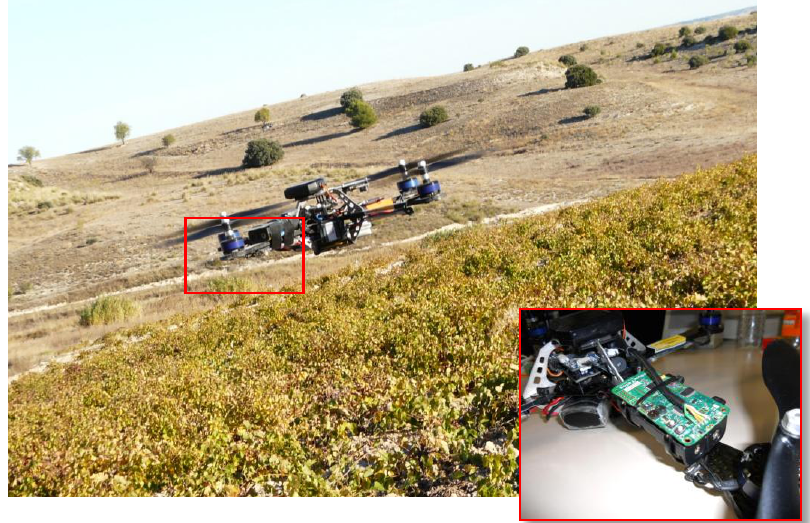
Figure 7. Quadrotor flying over the vineyards shipping a mote. The attached mote is depicted in the bottom right inset.